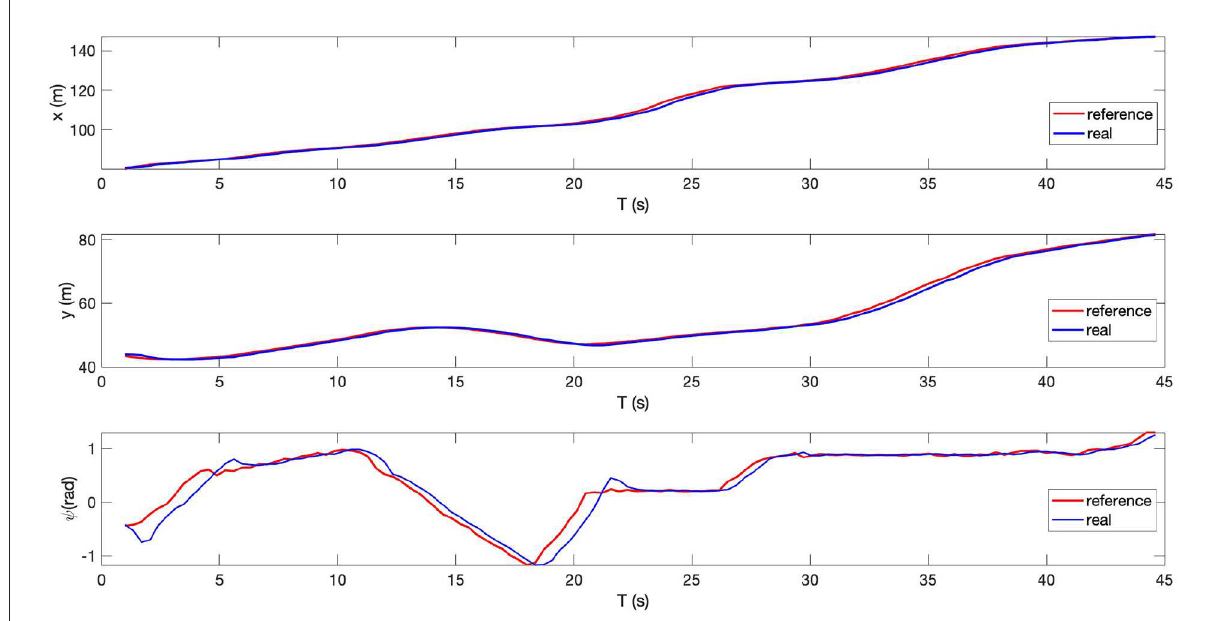
FIGURE14 Longitudinal position, lateral position, and yaw angle of the reference trajectory and of the baby stroller when following an arbitrary path.